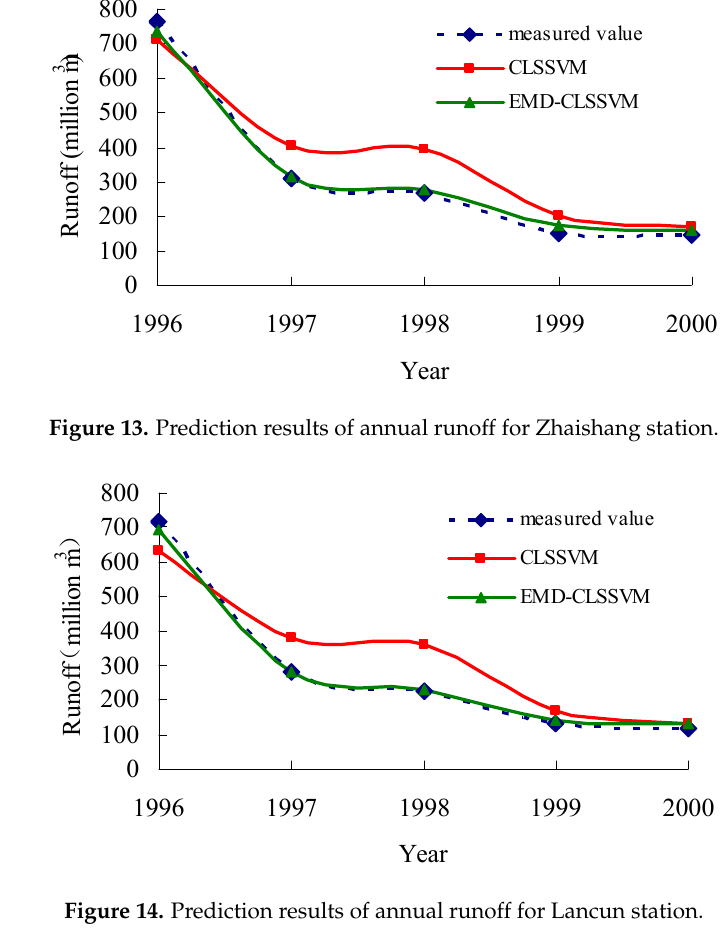
Figure 14. Prediction results of annual runoff for Lancun station.